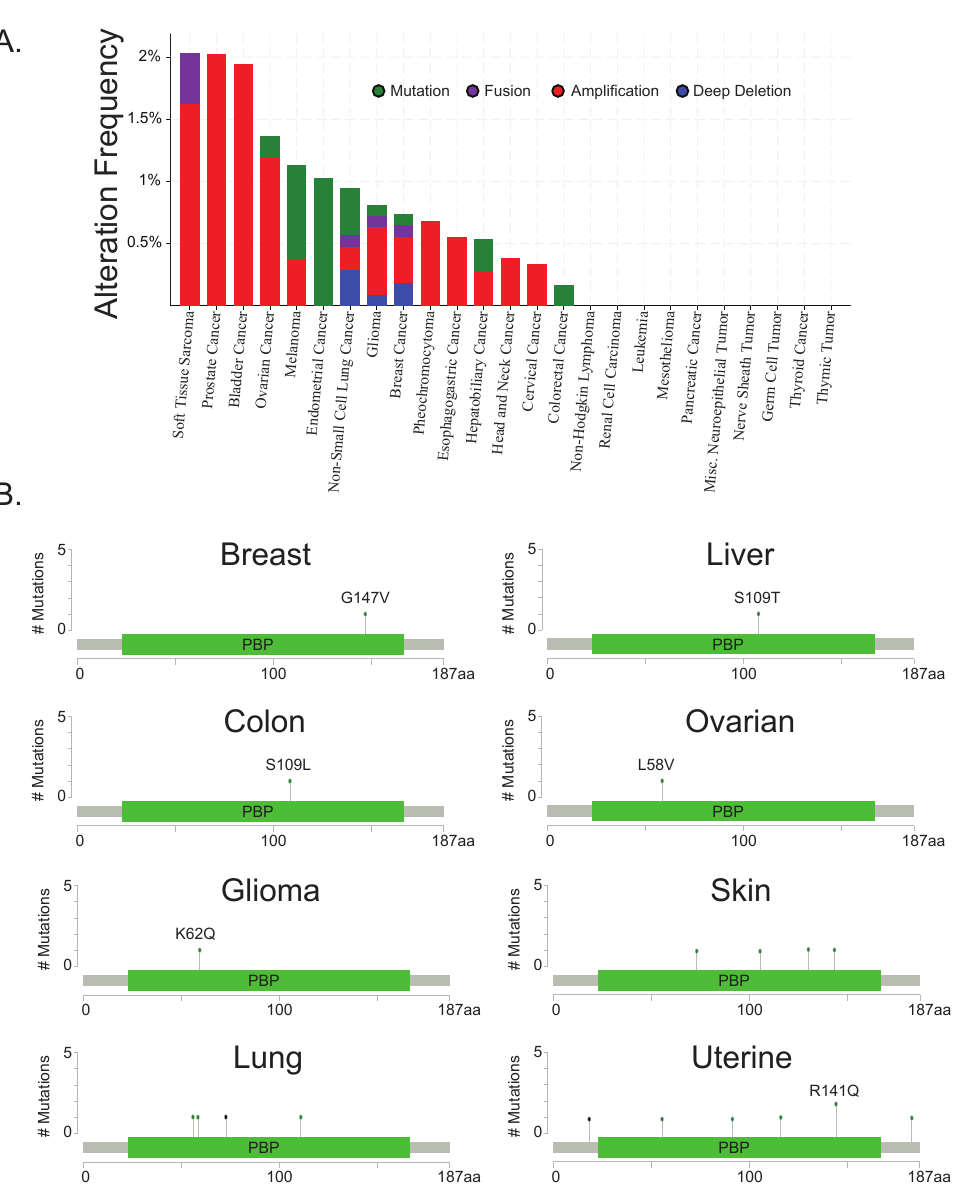
Figure 1. Raf kinase inhibitory protein (RKIP) downregulation in cancers cannot be explained by genetic deletions or mutations as it is rarely deleted or mutated in patient samples ( A ) Frequency of genetic alterations (mutations, fusions, amplifications, and deep deletions) in PEBP1 (RKIP) genes across multiple TCGA cancer types. ( B ) Residues on PEBP1 that have been found to be mutated in multiple TCGA cancers. Mutation and sequencing data were accessed through the cBioPortal data base (www.cbioportal.org) [17]. The graphs and figures were generated also on